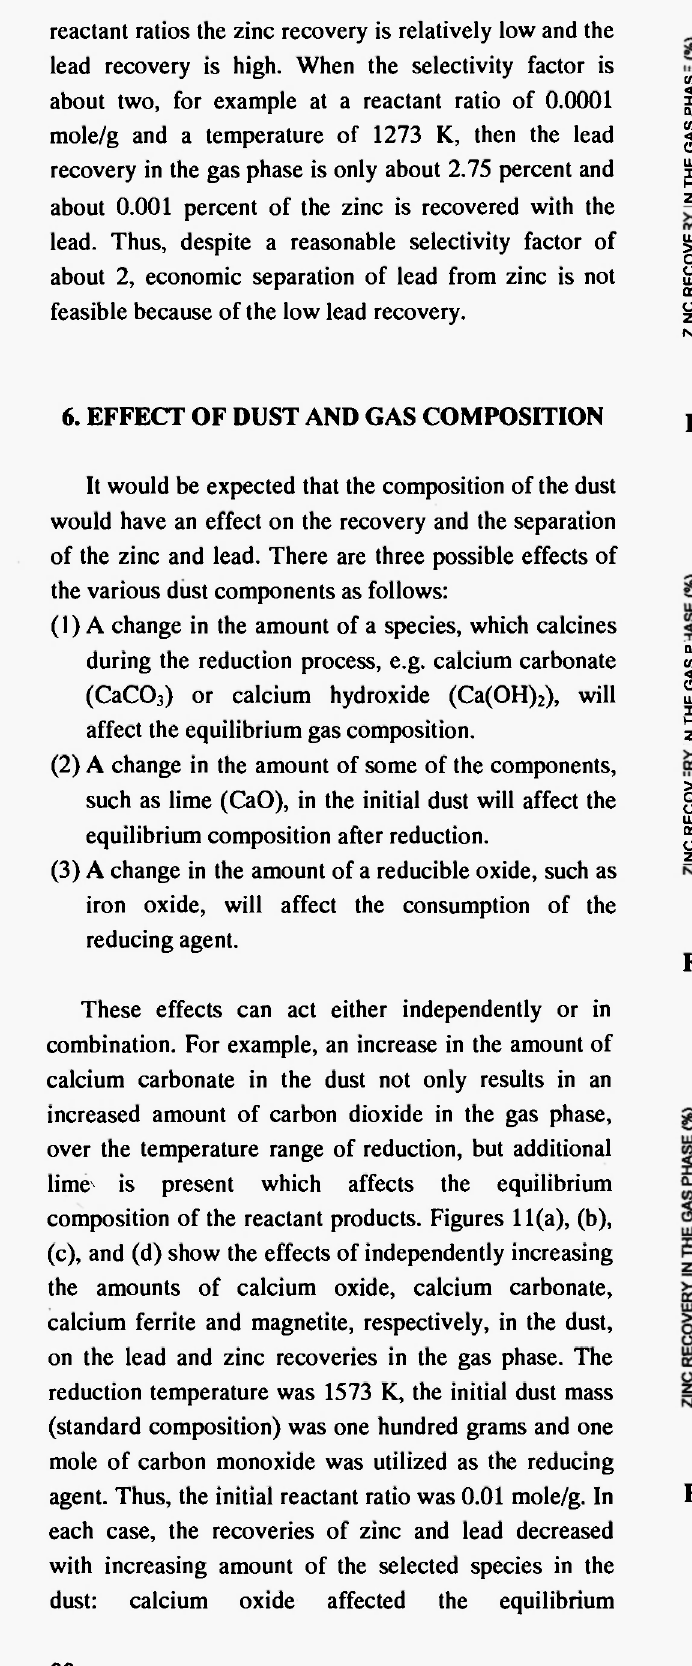
CALCIUM OXIDE CONTENT OF DUST (mass %) Fig. 11(a): Effect of the calcium oxide content of the dust on the zinc and lead recoveries for an input of one mole of carbon monoxide at 1573 K.